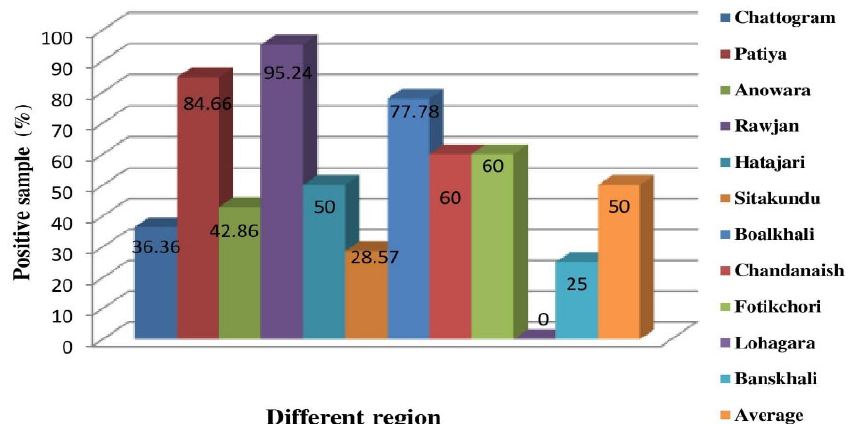
Fig. 3. Occurrence of colibacillosis and salmonellosis in different region of